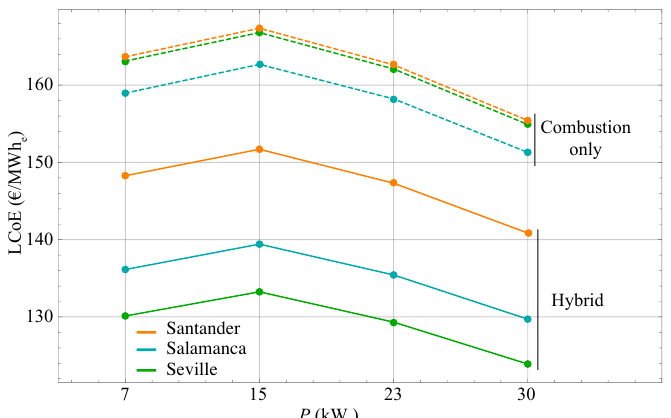
Figure 14. Levelized cost of electricity for two operating modes of the hybrid solar dish: combustion-only (dashed lines) and hybrid mode (solid lines). Four power output levels are considered, between 7 and 30 kWe.